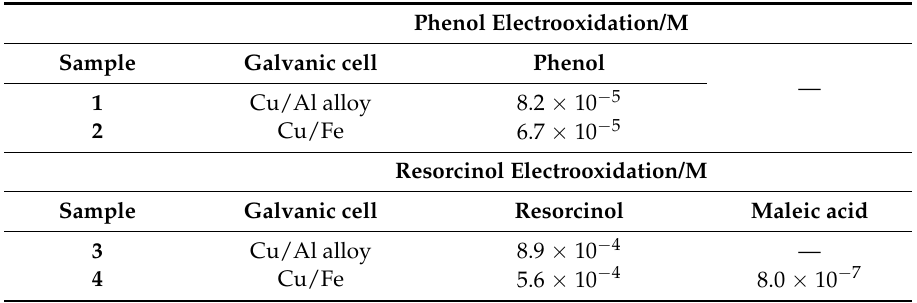
Table 2. Quantitative determination of phenol and resorcinol, and their possible electrodegradation products, obtained from phenol (resorcinol)-based, pre-electrolyzed synthetic wastewater solution, identified by means of HPLC/MS instrumental